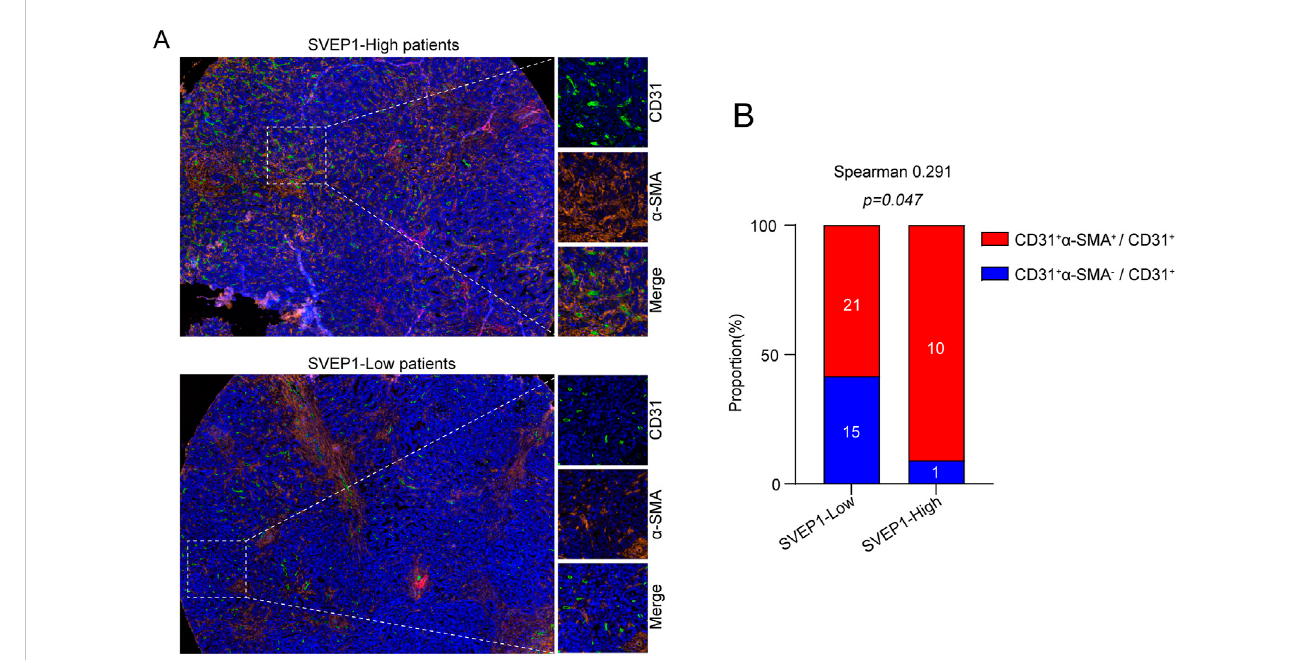
FIGURE 2 SVEP1iscorrelatedwithvesselnormalization. (A) Representativeimmuno fl uorescenceimagesofCD31 (green), α -SMA(orange),andDAPI(blue)staining in tumor tissues with high expression of SVEP1 or low expression of SVEP1. (B) Immuno fl uorescent image quanti fi cation results. Relative proportions of α - SMA + covered blood vessels in tumor tissues with high expression of SVEP1 or low expression of SVEP1, and the correlation analysis between CD31 + α -SMA + vessel rates and SVEP1